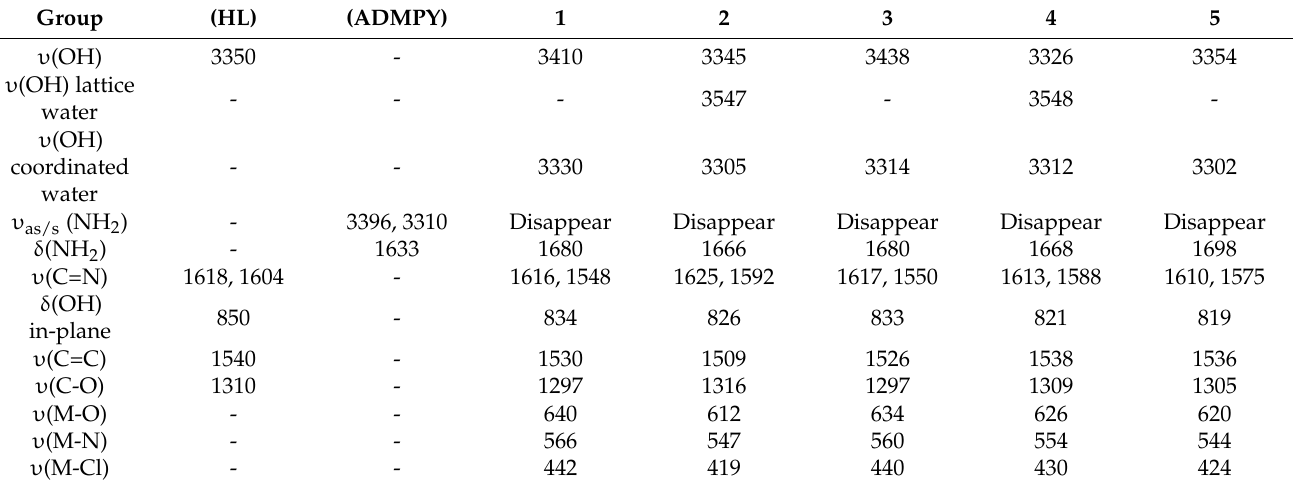
Table 1. FT-IR details spectral data (cm − 1 ) of free ligands and its metal